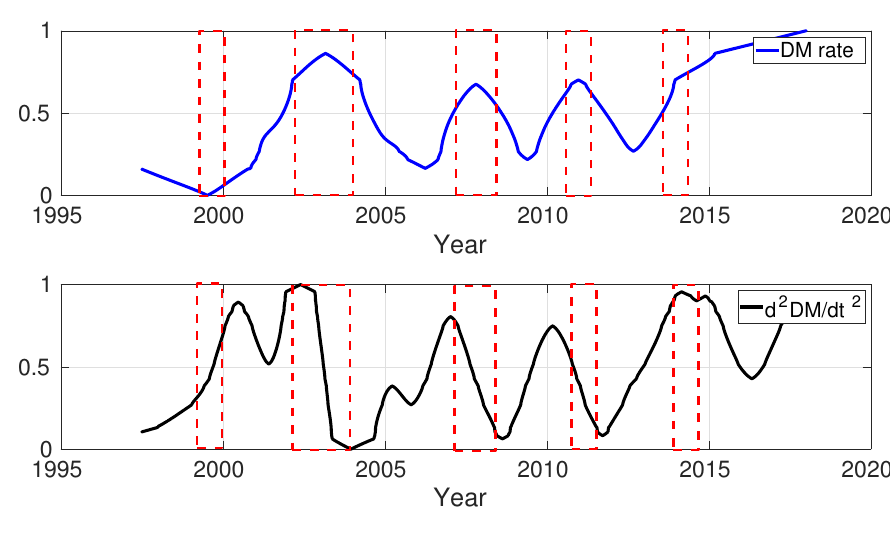
Figure 2. Time series of dDM/dt and d 2 DM/dt 2 obtained from CHAOS6 model.